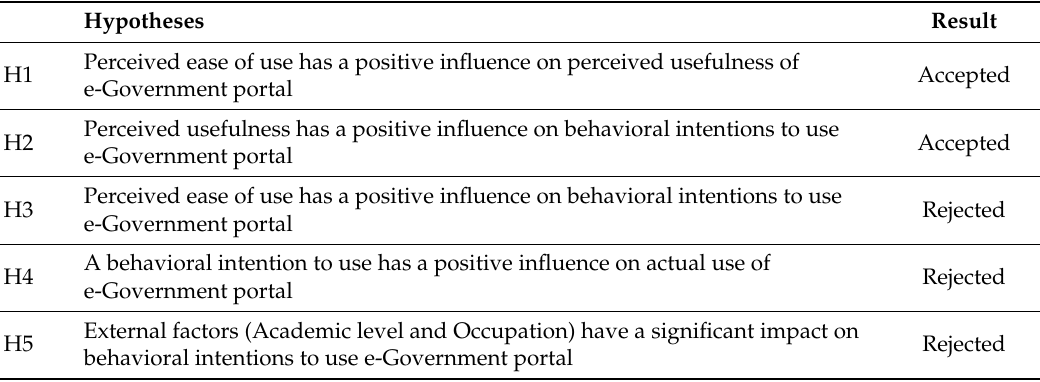
Figure 5. Results of hypotheses tests. Table 9. Summary of hypotheses